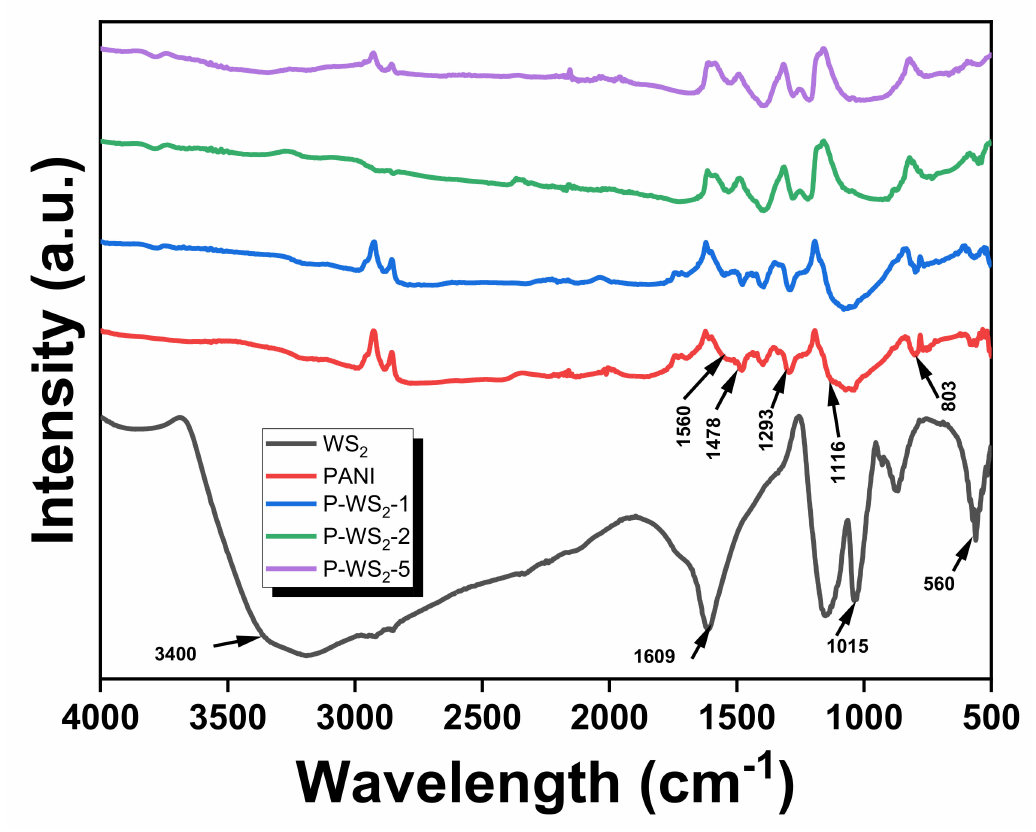
Figure 7. FT-IR spectra of bare WS 2 , bare PANI, and WS 2 -PANI (1–5)